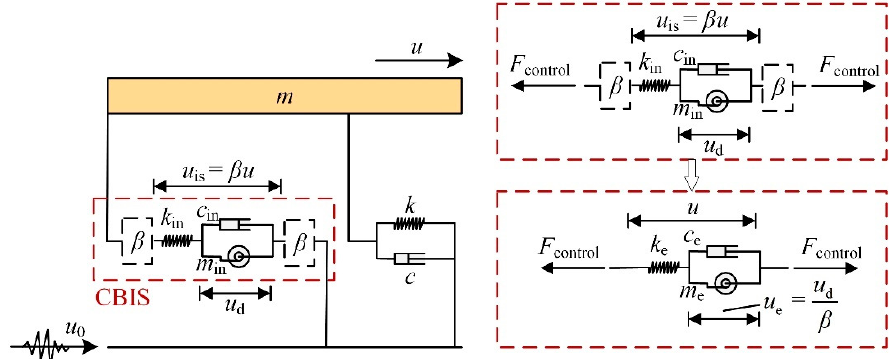
Figure 4. Schematic of the single-degree-of-freedom (SDOF) structure with a cable-bracing inerter system (CBIS).